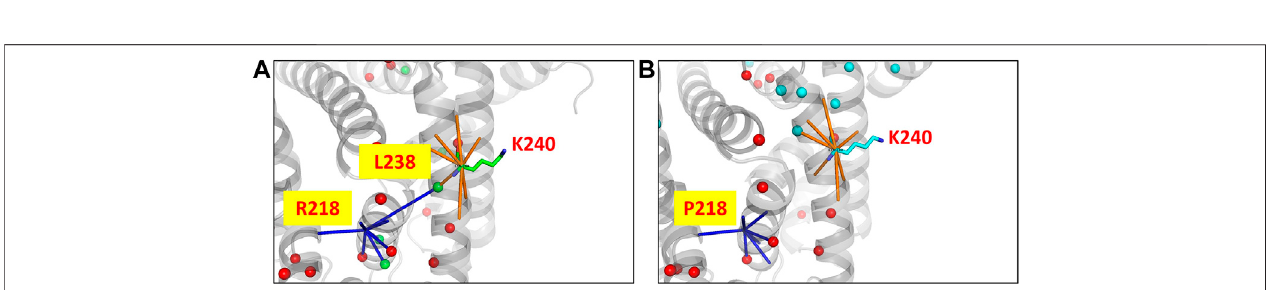
FIGURE5| ThePSNofhumanserumalbuminproteinatthesiteofmutationandfunctioninthewildtype(PDBID:1N5U)andmutant(PDBID:1HK3)isshown.The nodecorrespondingtothemutationsitemakesanedgewithahubnodeL238(greensphere)in (A) thewildtypePSNwhichislostinthecaseof (B) themutantPSN.Itis observed that hubs near to the binding site (K240) are lost, which is indicative of the increase in proximity between the nodes. It has been reported that the mutant structure is able to better accommodate a substrate with greater binding af fi nity which leads to the FDH disease condintion. Hubs unique to the wildtype and mutant are show in green and cyan sphere representation respectively, those hubs that are retained are shown in red.